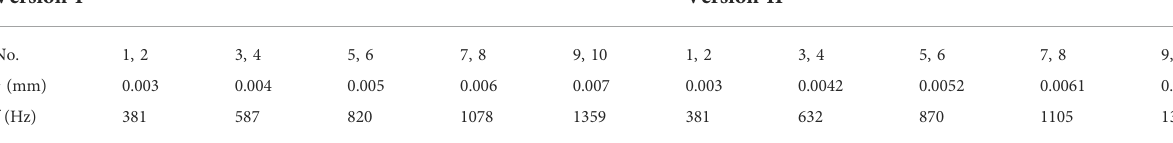
TABLE 2 Modi fi ed parameter e of the pairs of internal oscillators (No.) and the corresponding fundamental frequency f in two versions: Version I (linearly increasing e , nonlinearly increasing f ) and Version II (linearly increasing f , nonlinearly increasing e ). Version